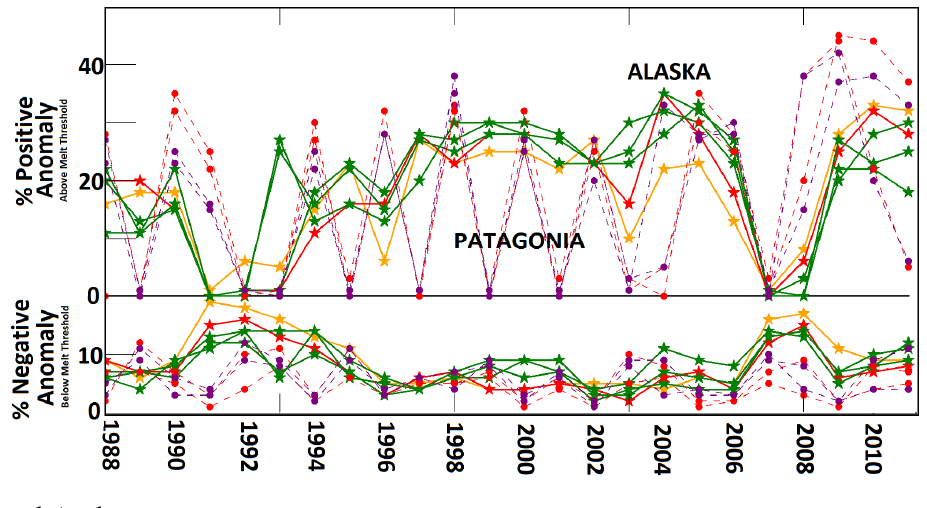
Figure 7. Time series (1988–2011) of the percentage of positive (and negative) T anomalies above (and below) the melt threshold (246 K) for each year for the Alaska transect pixels (stars and solid lines) and for the Patagonia Icefield transect (circles and dashed lines) (see Figures 3 and 4 for locations). Line colors correspond to the pixel’s characteristic melt regime (see key Figure